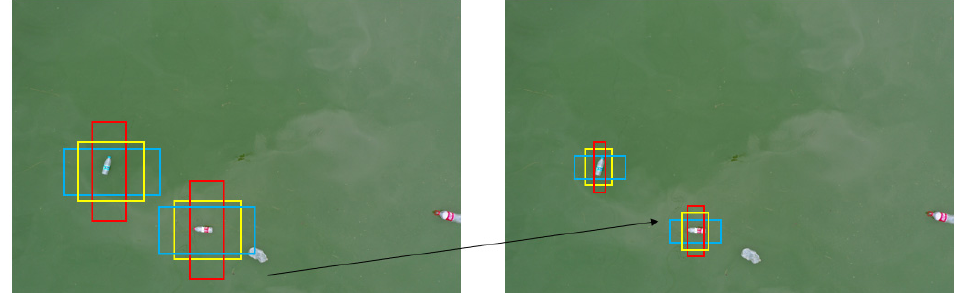
Figure 6. Modification of anchor structure.